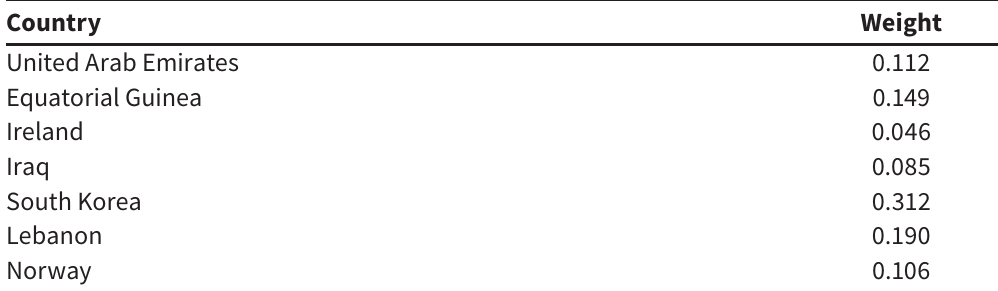
Weights for Constructing Synthetic Puerto Rico (GDP Matching) Country